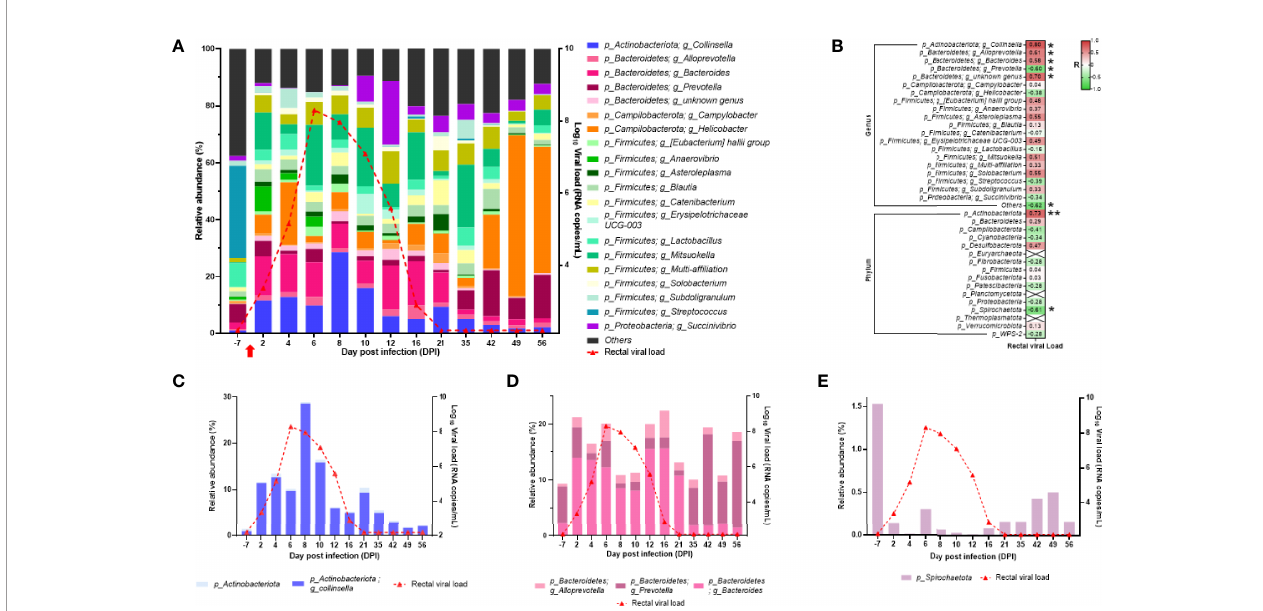
FIGURE 11 | Analyses of the neonate rectal microbiota composition. (A) Bar plots represent the rectal microbiota composition. Relative abundance is represented for each time point (left scale). The red curve represents the rectal viral RNA load (logarithmic scale) of SARS-CoV-2 detected in neonate over time (right scale). (B) Spearman correlation analysis between the SARS-CoV-2 rectal viral RNA load and the rectal microbiota composition. On the heatmap, the correlation factors of each phylum or genus are represented according to the rectal viral RNA load. Correlation factors are indicated on a red to green scale. * p < 0.03; ** p < 0.001. (C) Actinobacteria (phylum) and Collinsella (genus) relative abundance (left scale) overlapped with rectal viral RNA load on the logarithmic scale (right scale). (D) Alloprevotella , Bacteroides , and Prevotella (genus) relative abundance (left scale) overlapped with rectal viral RNA load on the logarithmic scale (right scale). (E) Spirochaetota (phylum) relative abundance (left scale) overlapped with rectal viral RNA load on the logarithmic scale (right